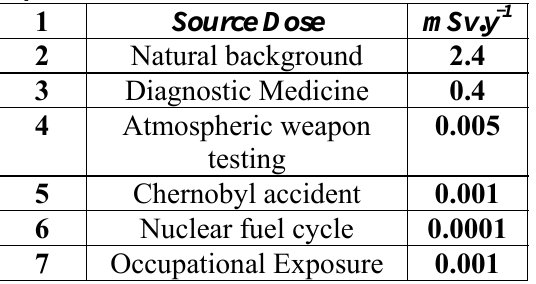
Table 2: Average annual effective dose per